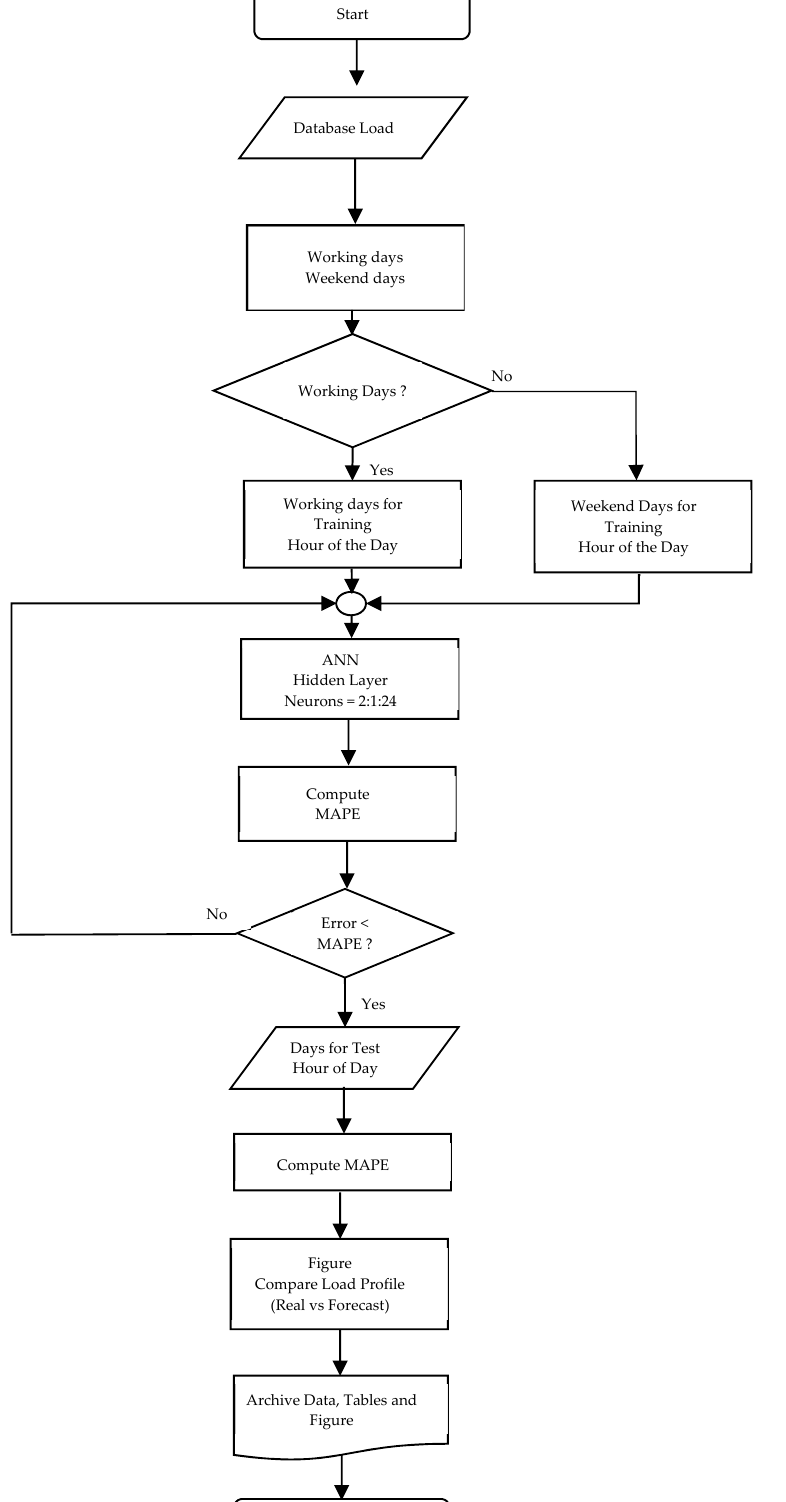
Figure 2. Proposed flowchart to optimize the MAPE. During training, the progress is constantly updated in the training window. The most interesting are the gradient magnitude, number of cross-validation checks, and performance value. The magnitude of the gradient and number of cross-validation checks are used to terminate the training process. The gradient becomes smaller as the training